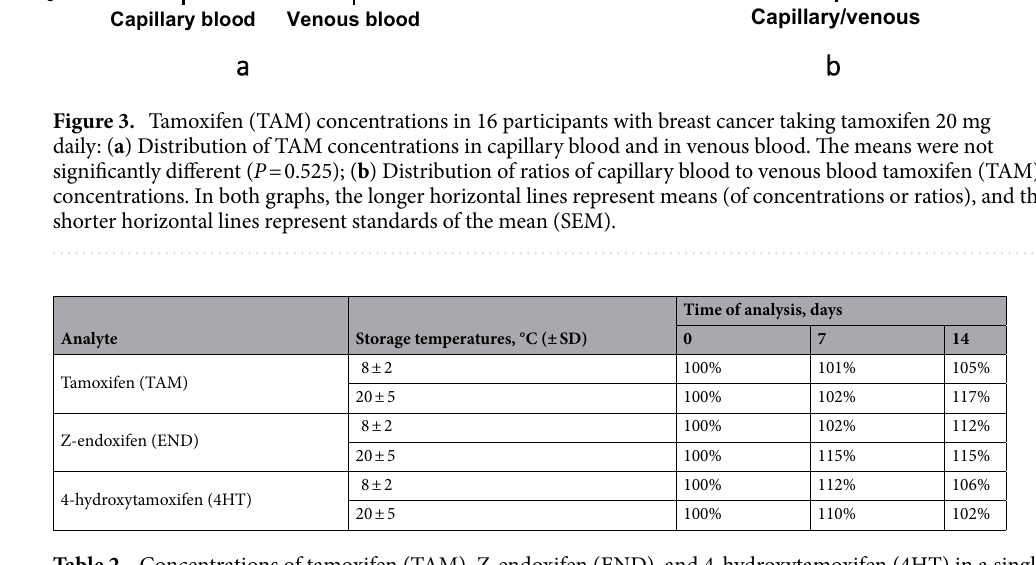
Table 2. Concentrations of tamoxifen (TAM), Z-endoxifen (END), and 4-hydroxytamoxifen (4HT) in a single patient with breast cancer receiving tamoxifen 20 mg daily, from whole blood samples stored at refrigerator and room temperatures in the dark, and analyzed 7 and 14 days after samples obtained, with results expressed as percentages of initial analyte concentrations. SD, standard deviation.